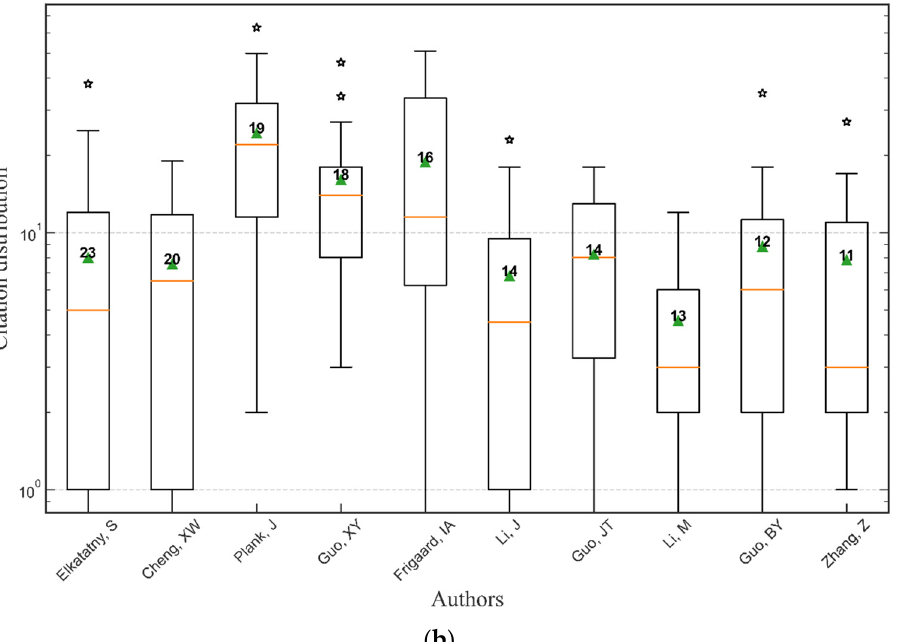
Figure 9. ( a ) The giant connected component of author collaboration network with at least five papers generated by VOSviewer. ( b ) Top 10 most scientific influence corresponding authors. The asterisk in figure indicates the outliers.